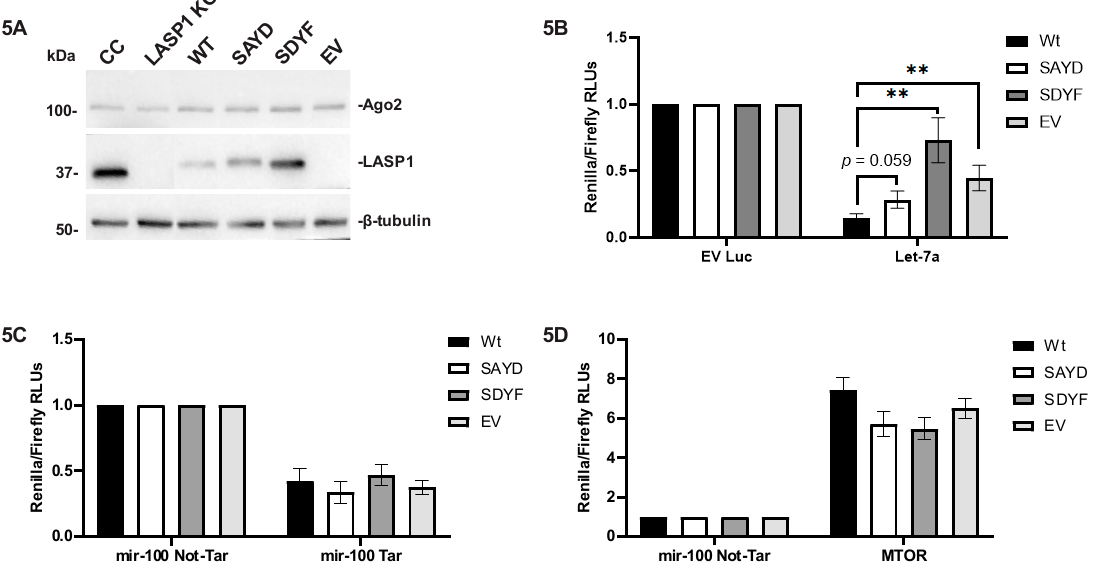
Figure 5. LASP1 Alters Let-7a Guided Ago2 Activity. ( A ) Stable ectopic expression of LASP1 WT and its mutants SAYD and SDYF in the LASP1-KO background. Total lysates from Bone-Un CRISPR control (CC) and LASP1-KO (LASP1 KO) as well as the LASP1-KO cells with expression of re-introduced LASP1 WT and its doublemutants: pcDNA 3.0 empty vector (EV) control, LASP1 wild-type rescue (WT), dominant active phospho-mutant LASP1 (SAYD), and dominant-negative phospho-mutant LASP1 (SDYF). 20 µ g of total was resolved by 10% SDS-PAGE and immunoblotted for LASP1. ( B – D ) Luciferase assays in LASP1 rescue cell lines with dual-luciferase reporters. LASP1 rescue cell lines WT, SAYD, SDYF, and EV were incubated overnight with 4 µ g of each psiCHECK2 dual-luciferase vector containing an internal firefly luciferase control and experimental Renilla luciferase including no 3 (cid:48) -UTR (EV Luc), artificial 3 (cid:48) -UTR containing Let-7a target sites (Let-7a), artificial 3 (cid:48) -UTR containing miR-100 target sites (miR-100 Tar), artificial 3 (cid:48) -UTR containing miR-100 target sites with mis-matched seed sequences (miR-100 Not-Tar), and the inserted 3 (cid:48) -UTR of the mTOR mRNA (mTOR). Cell lysates were harvested from each condition and relative luciferase units (RLUs) measured by luminometer. Final readings for each condition was expressed as the ratio of Renilla to firefly RLUs with Let-7a compared against EV Luc ( B ), miR-100 Tar vs. miR-100 Not-Tar ( C ), and mTOR vs. miR-100 Not-Tar ( D ). All experiments performed n = 3 with eight technical replicates per experiment. Uncropped version of the Western Blots is available in Figure S7. ** p <